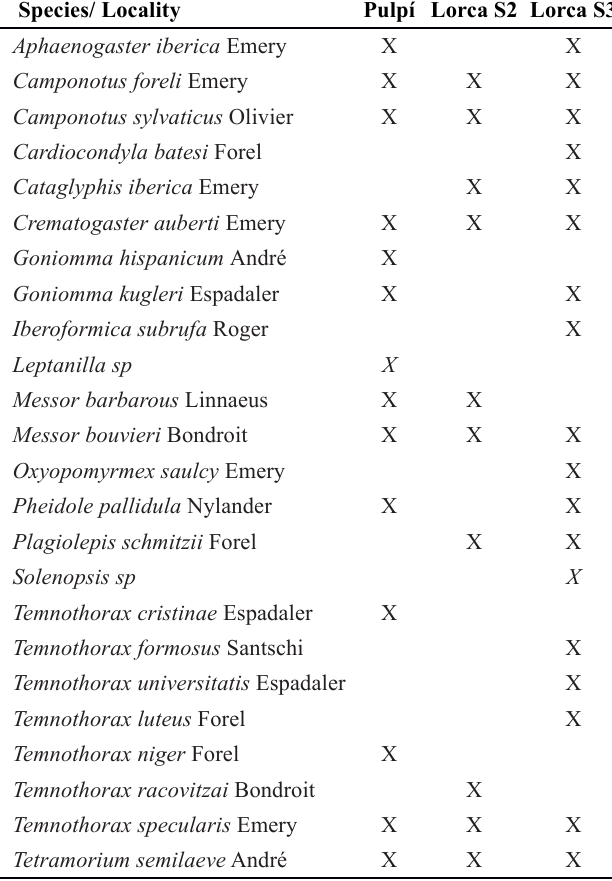
Table 2 . Ant species sympatric with Temnothorax ansei sp.n. Species/ Locality Pulpí Lorca S2 Lorca